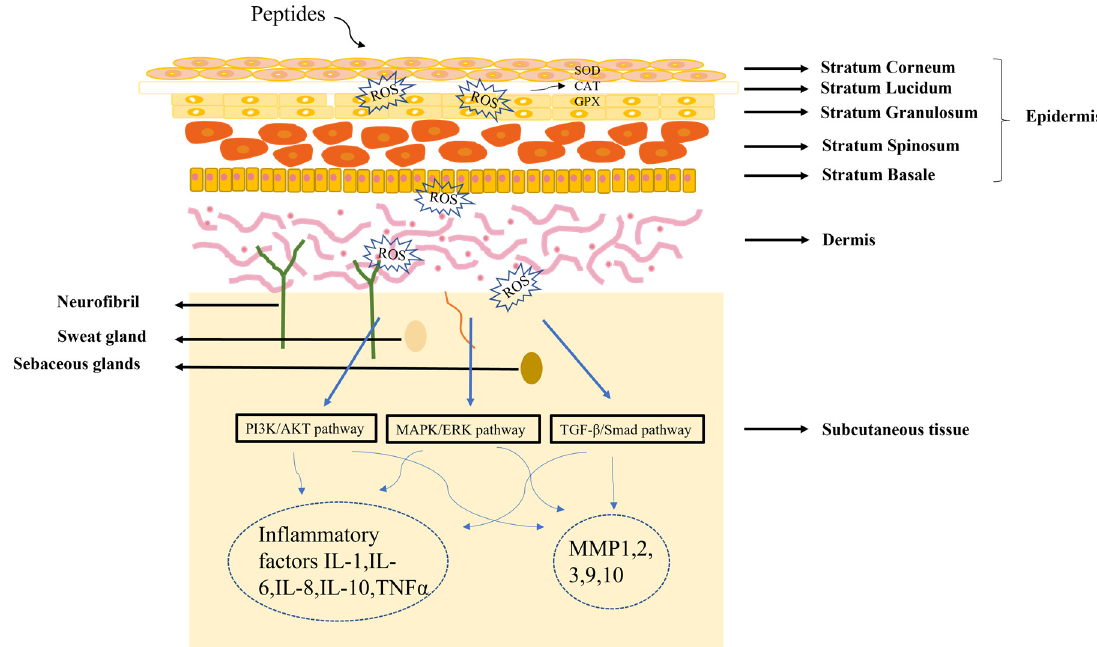
Figure 2. Diagram of the mechanism of peptide treatment of skin damage.